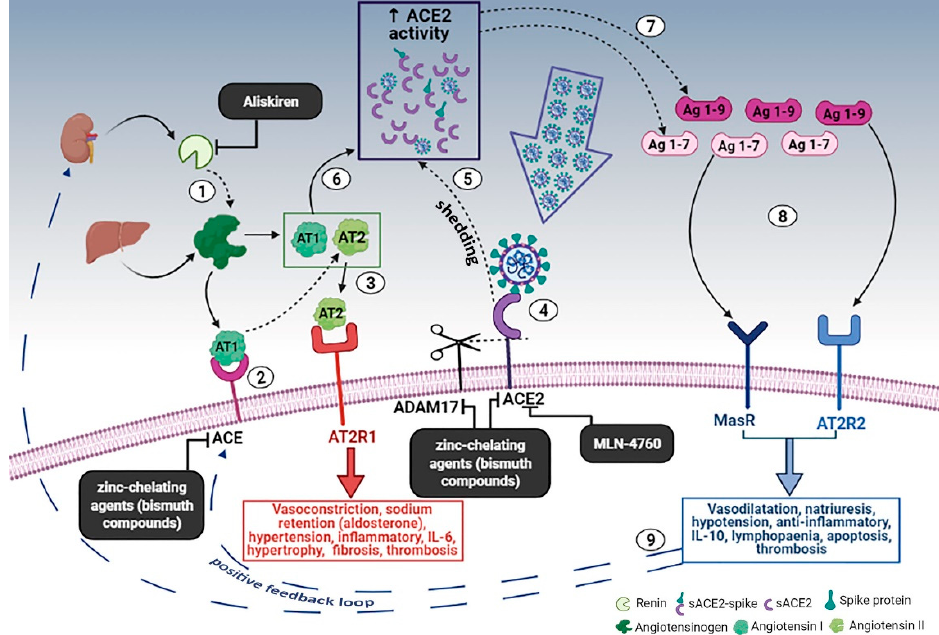
Figure 1. Schematic diagram of the effects of RAAS system during SARS-CoV-2 infection and the proposed therapeutic treatment. (1) Renin secreted, by the kidney, cleaves angiotensinogen, produced by liver, to form AT1, (2) AT1 is converted to AT2 by pulmonary ACE. (3) AT2 binds to AT2R1 (Angiotensin II receptors 1). The excess of AT2 through AT2R1 hyperactivation causes vasoconstriction, sodium retention (by aldosterone release), hypertension, inflammatory, IL-6, hypertrophy, fibrosis, thrombosis. (4) SARS-CoV-2 binds to ACE2 to gain entry into the host cell, however, cellular protective response leads to ACE2 shedding. (5) ADAM17-regulated ectodomain shedding of ACE2 results in increased amount of soluble and active ACE2 (sACE2). (6) AT1 and AT2 can also bind to sACE2. (7) They are then metabolized by ACE2 into Ag 1–9 and Ag 1–7, respectively. (8) The excess of Ag 1–9 and Ag 1–7 signaling via the AT2R2 and MasR can induce vasodilatation, natriuresis, hypotension, anti-inflammatory, IL-10, lymphopenia, apoptosis, thrombosis. (9) These events, in turn, produce a compensatory upregulation of both renin secretion and ACE activity, which establish the onset of a positive feedback loop. In the black boxes, drugs that can potentially to stop the positive feedback loop, by inhibiting enzymes of the RAAS, are indicated. Dashed arrows indicate enzymatic activity, full arrows indicate non enzymatic passage and dashed blue arrows represent the positive feedback loop. Created in Biorender.com.